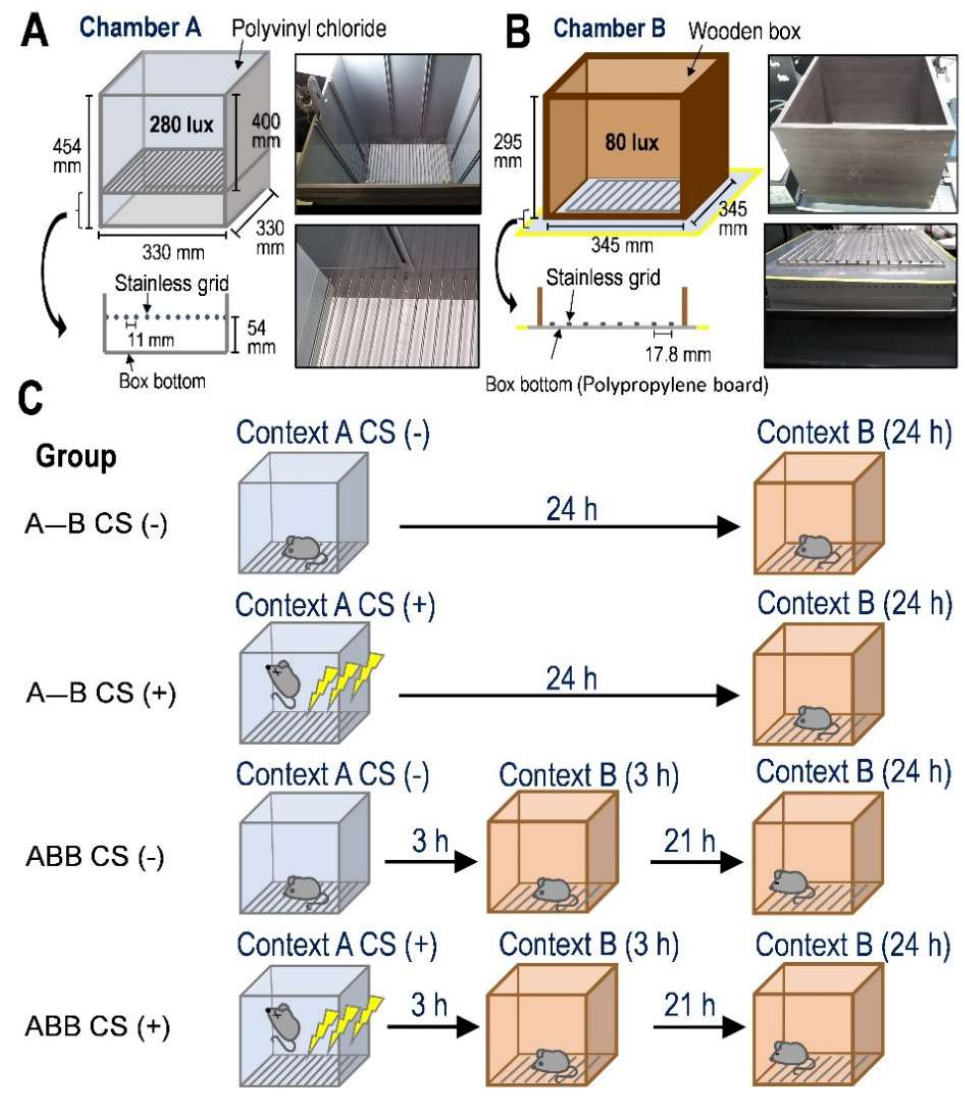
Figure 1. The two boxes used in the present study and the experimental paradigm for the contextual fear memory test. ( A ) Illustration of the schematic representation of Box A for contextual fear conditioning. The right two panels are photographs of Box A. Upper panel represents Box A from the diagonal above Box A, and the lower panels show the grid floor in detail. There is a 54-mm spacing from the grid to the bottom. A paper towel covered the bottom. The brightness in Box A was kept at 280 lux. ( B ) Illustration of the schematic representation of Box B for Context B. The four walls were made of brown wood, and the brightness was kept at 80 lux. The stainless-steel grid was sheeted directly on the bottom with no space between the grid and the bottom. The right two panels are photographs of Box B. Upper panel represents Box B from the diagonal above Box B, and the lower panel shows the grid floor in detail when the four walls are removed. ( C ) Experimental paradigms for contextual fear memory for A-B CS ( − ), A-B CS (+), ABB CS ( − ), and ABB CS (+) groups. Electric shocks (1.0 mA for 2 s × 3 times at 100 s intervals) were delivered to the mice for CS (+). A similar freezing level during Context A in Box A was observed in A-B CS (+) and ABB CS (+) mice (Figure 2A). In contrast, freezing behavior was not observed in A-B CS ( − ) and ABB CS ( − ) mice (Figure 2A). Two-way repeated measures analysis of variance (ANOVA) revealed that the electric shocks and the time affected the freezing level ( F (3, 37) = 15.01, p < 0.01, Figure 2B, Table 1). We observed that the false fear memory was formed in Box B at 3 h, as the freezing level in ABB CS (+) mice 3 h after the CS